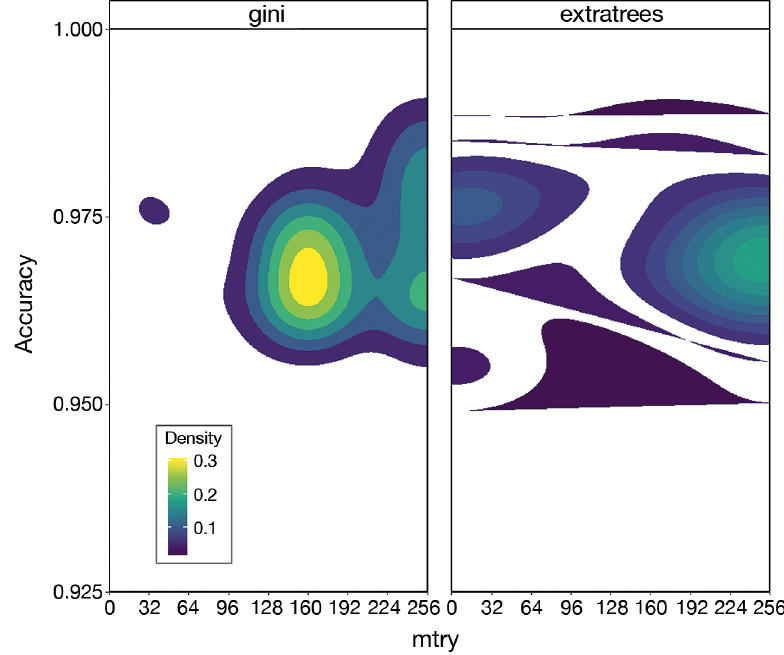
1. Cross-validation performance of predictive models with varying hyper- parameters. Shown are the accuracy of aggregated validation scores created through repeated 10-fold cross validation on the vertical axis, with the number of randomly selected features as split candidates (‘mtry’) indicated on the horizontal axis. The density of models reporting similar performance and hyperparameters is indicated by warmer colors. The left and right plots corre- spond to gini and extratrees (‘splitrule’), respectively, which determine how the algorithm creates decision tree